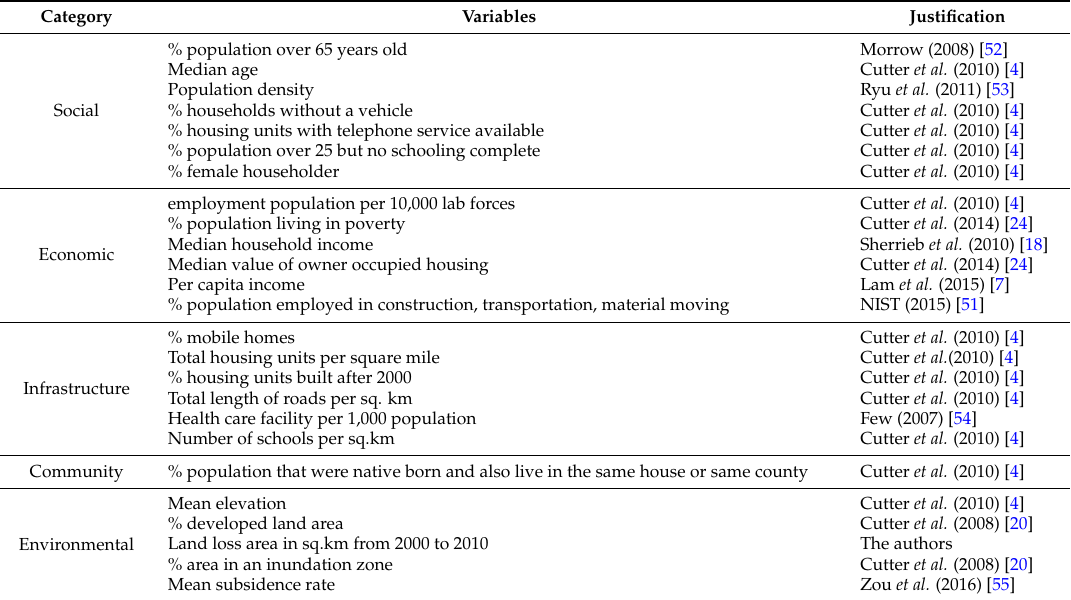
Table 1. Resilience